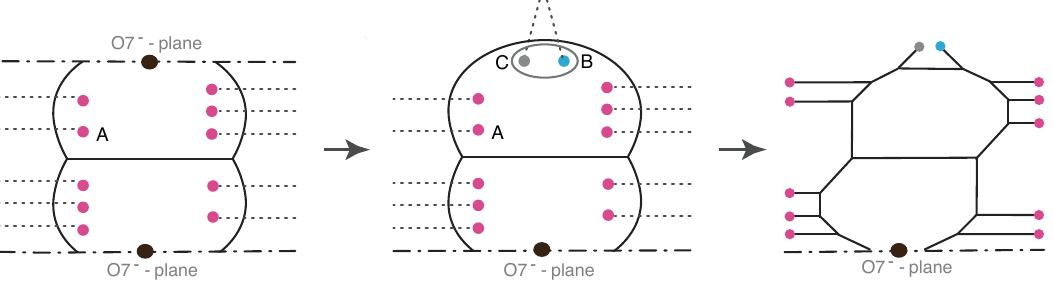
Figure 4 . Type IIB brane descriptions for 6d = (1 ; 0) Sp( N ) gauge theory with one tensor N multiplet and 2 N + 8 (cid:13)avors in the fundamental representation, which yields = 1 Sp( N + 1) N gauge theory with the number of (cid:13)avors. For simplicity, N = 1. Left: the brane con(cid:12)guration with two O 7 (cid:0) planes. Middle: the brane con(cid:12)guration with only one of two O 7 (cid:0) planes is resolved. Right: the resulting Sp(2) gauge theory with N f = 10